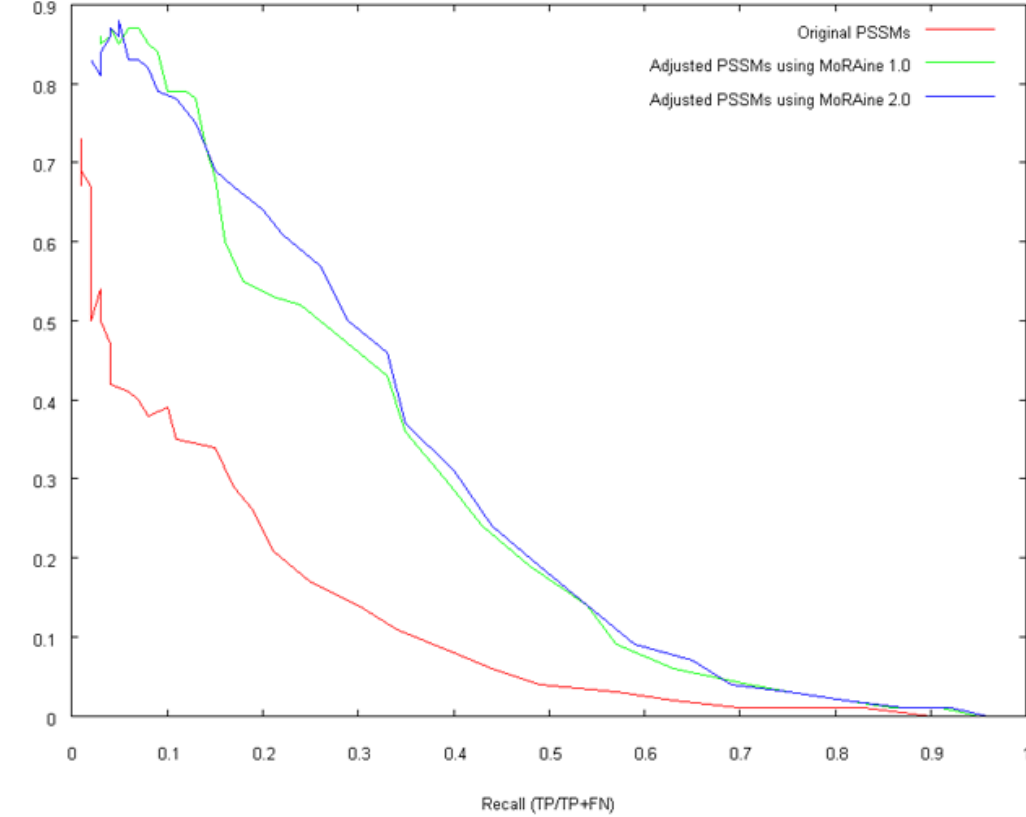
Figure 2: Prediction performance comparison of PoSSuMsearch by means of precision and re- call. All values are measured for varying p-value thresholds based on PSSMs learned from the original TFBSs (red line) compared to those of readjusted TFBSs with MoRAine 2.0 (blue line) and readjusted TFBSs with MoRAine 1.0 (green